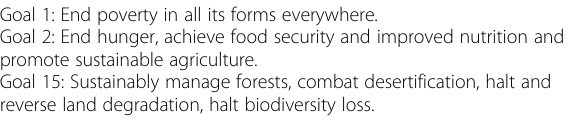
Table 1 Three of the Sustainable Development